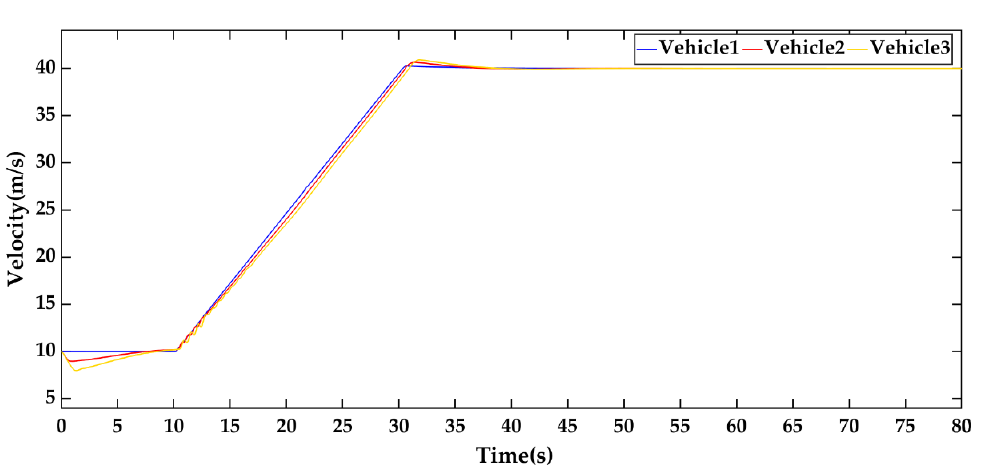
Figure 10. The velocities of the following vehicle under the improved MPC strategy in Scenario 1. From Figures 9 – 12, the velocities and accelerations of vehicle 2 and vehicle 3 were compared with the standard and the improved MPC strategies. The velocity was gradu- ally adjusted to 30 m/s after 30 s, and the accelerations were stable at 0. However, vehicle 2 and vehicle 3 showed their deceleration at the beginning of the standard MPC strategy. When vehicle 1 accelerated, the acceleration of the following vehicle under the improved MPC strategy was very small, which facilitated the convergence rate of the acceleration. In the same state of vehicle 1, the fluctuations in the accelerations of the following vehicles occurred under the standard MPC between 10 s and 20 s, which was caused by the accel- eration at 10 s. As shown in Figure 12, after vehicle 1 suddenly accelerated, the maximum acceleration of vehicle 2 could be up to 1.7 m/s 2 , which reflects the moderate acceleration control of the improved MPC strategy. The accelerations in Figures 11 and 12 reflect that the change rate of acceleration of the standard MPC strategy is greater than that in the improved MPC strategy, which affects the fuel consumption and emissions of the vehicle. In addition, it can be seen from the maximum acceleration in these two figures that the improved MPC strategy was more adaptable to constraints compared to the standard MPC strategy.